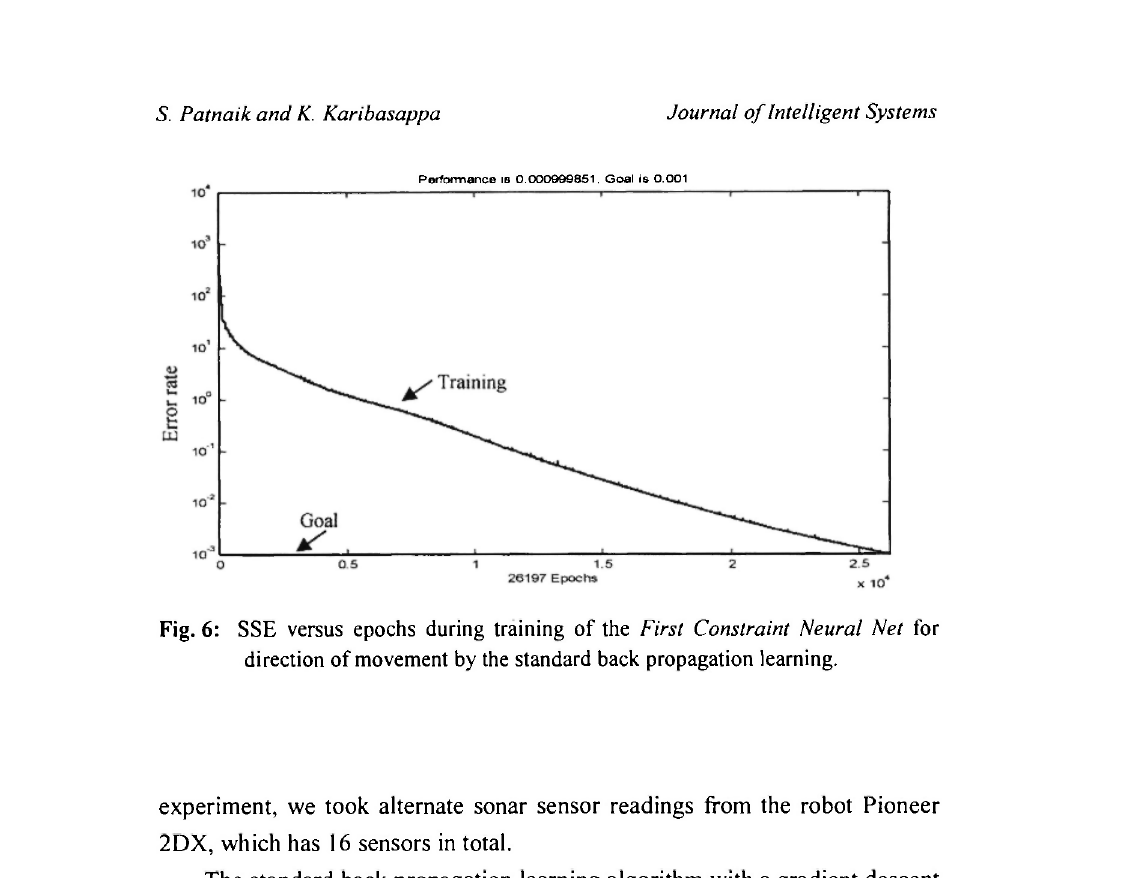
Fig. 6: SSE versus epochs during training of the First Constraint Neural Net for direction of movement by the standard back propagation